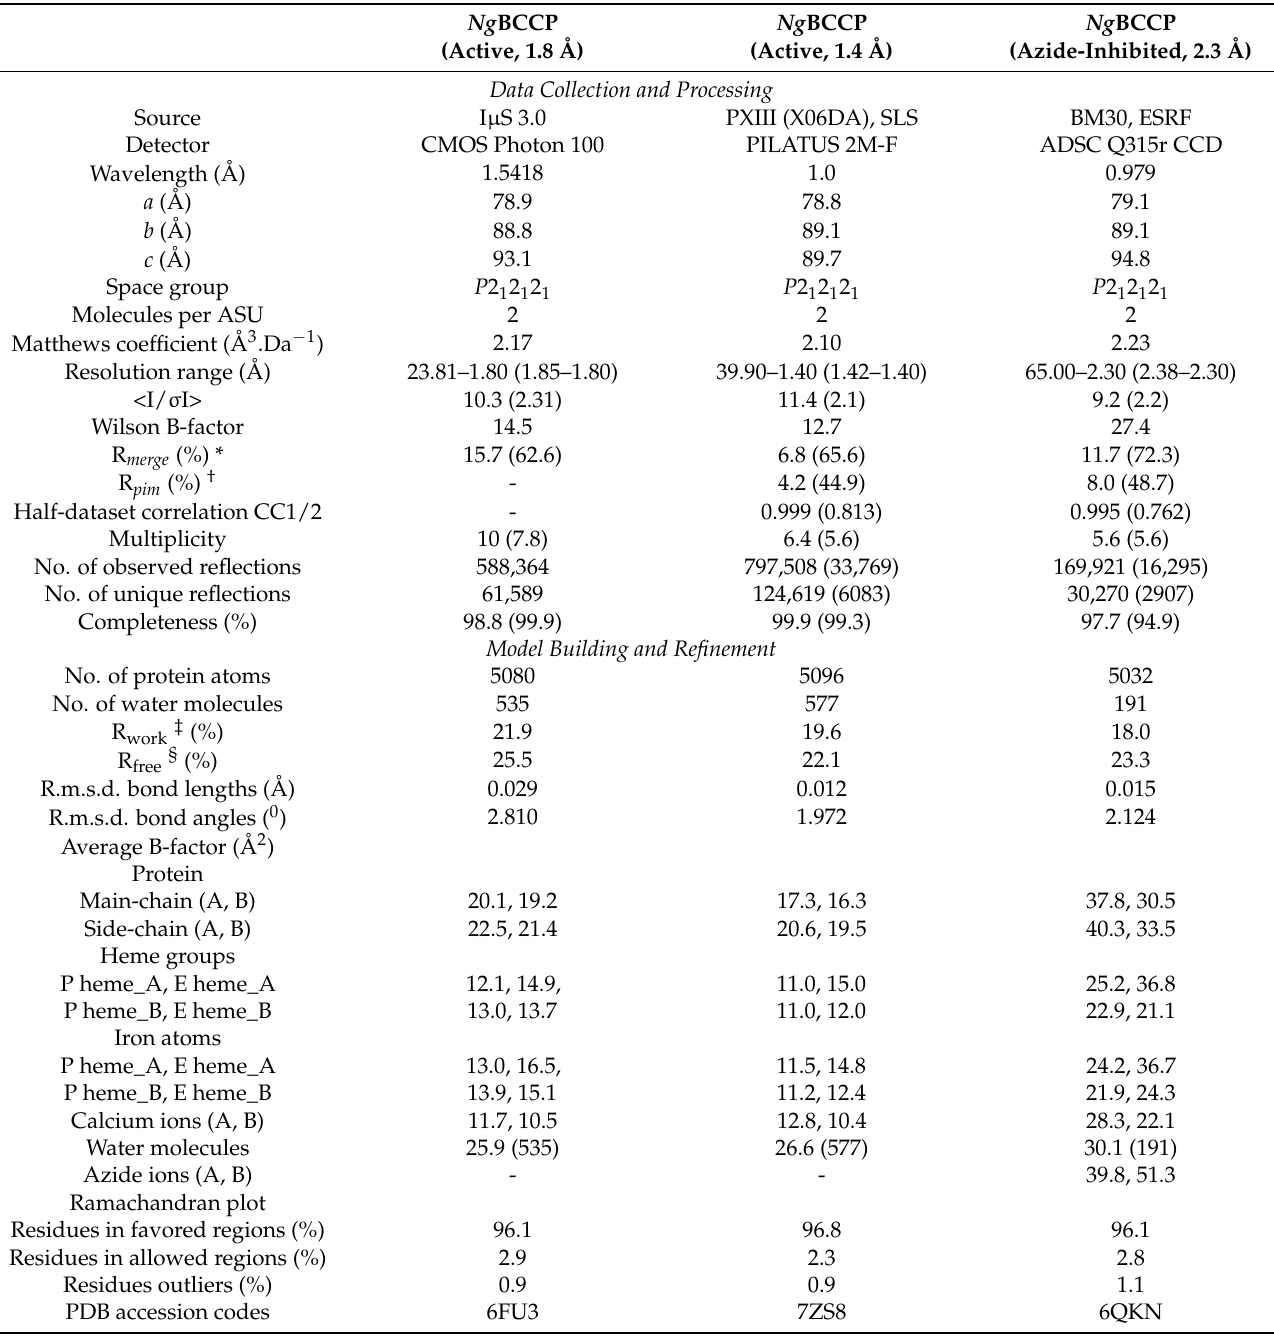
Table 1. Statistics of data collection, processing, model building and